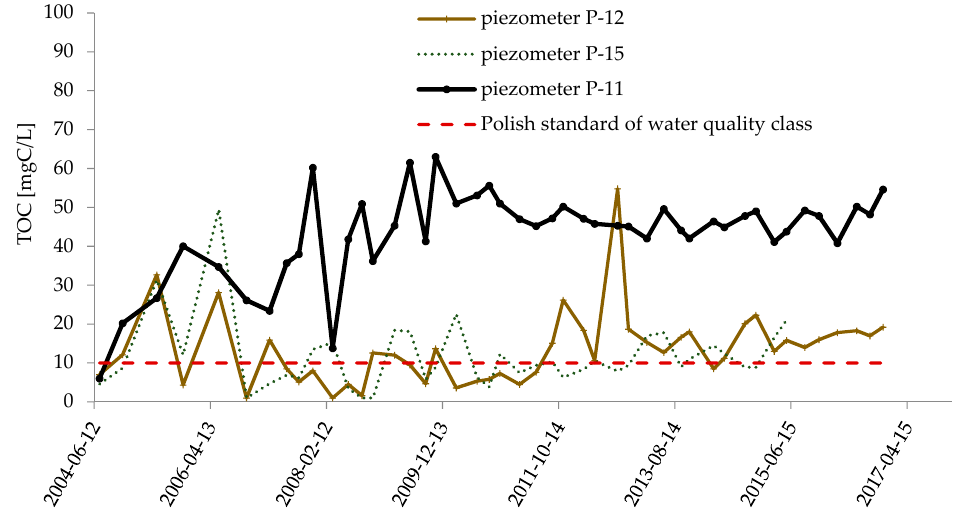
Figure 13. Temporal changes of the TOC level in piezometers located in the area of composting plant.